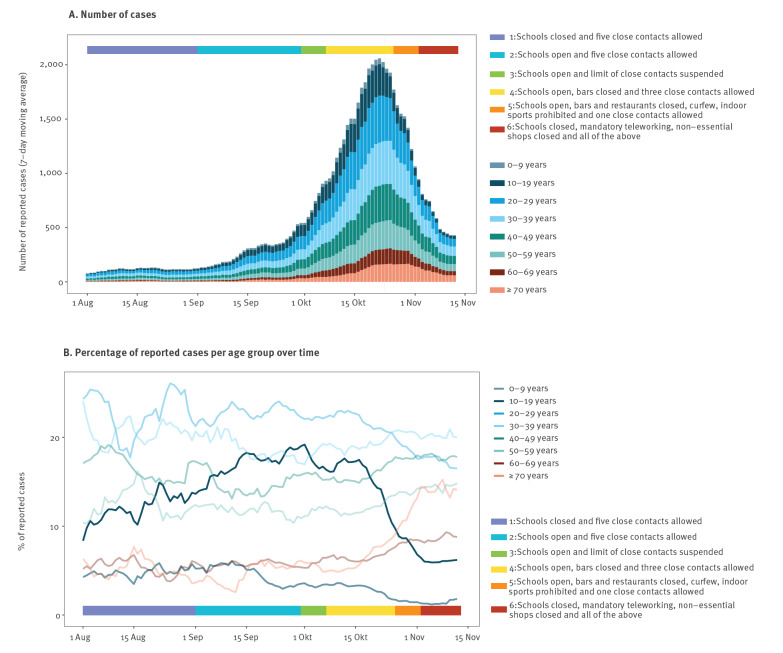
7-day moving average of SARS-CoV-2 confirmed cases reported, Brussels region, Belgium, 1 August–12 November 2020 (n = 415,412)